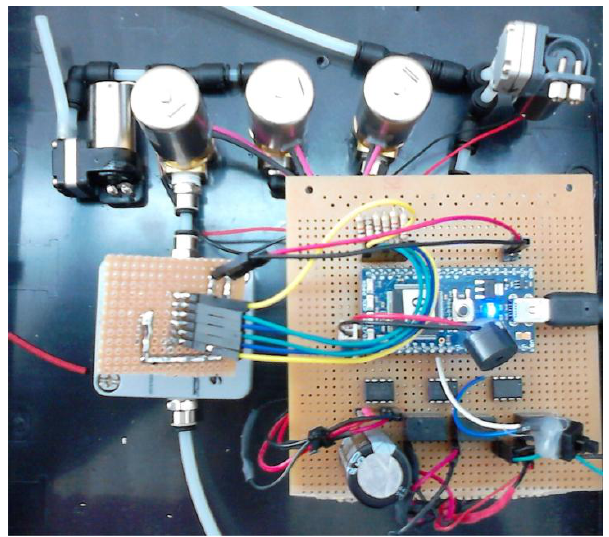
Figure 2. CAPINose electronic nose.